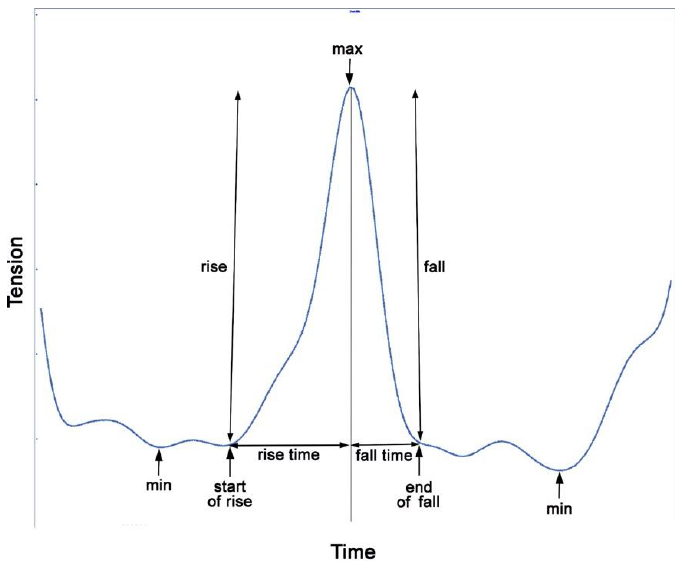
Figure 8. A single rein tension spike from a trotting horse with additional data at the start and end of the spike. The discrete variables extracted and calculated from the data are indicated. A typical single rein tension spike starts at the inflexion where tension begins to rise rapidly to a maximum, after which it decreases rapidly until the trace makes an inflexion at the end of the rapid decrease. An initial minimum (start of rise), a maximum and a final minimum (end of fall) value can be measured. This pattern is still more or less obvious when other (smaller and larger) peaks are superimposed.